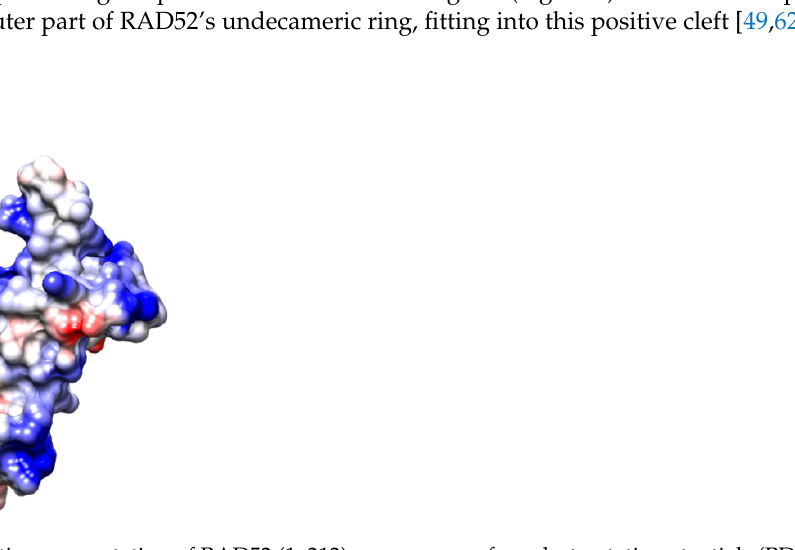
Figure 6. Schematic representation of RAD52 (1–212) monomer folding. Rods and arrows indicate helices and strands, respectively.